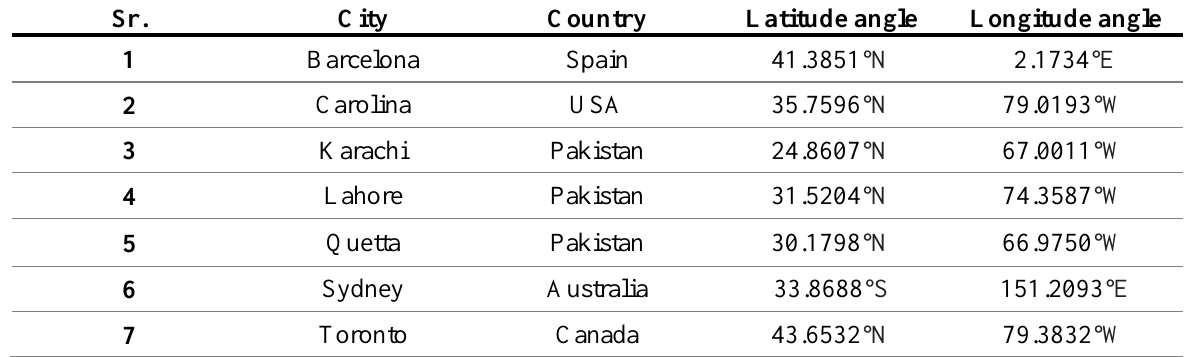
Table 2. Details about used locations in the study [7] Sr.